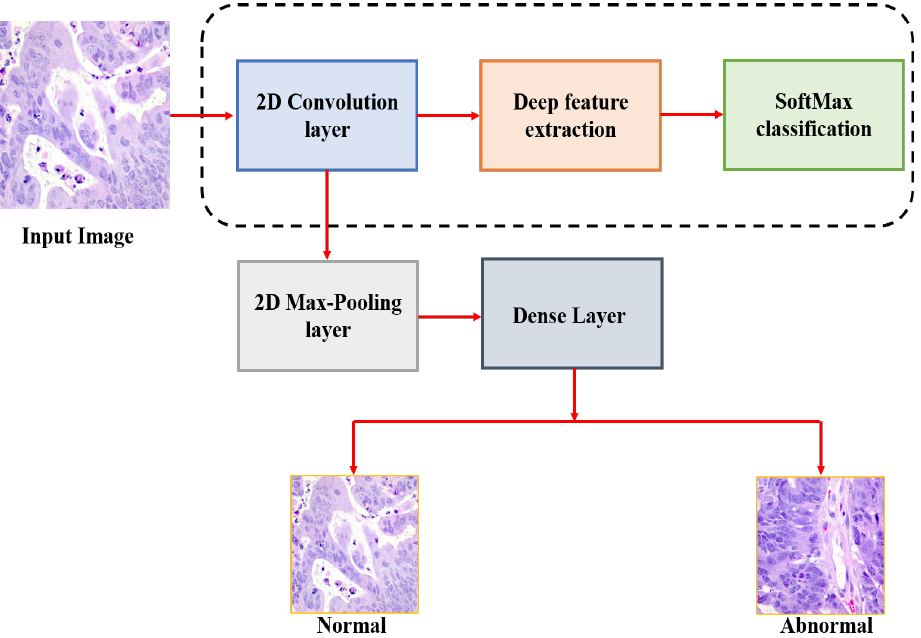
Figure 2. General Architecture of the Proposed